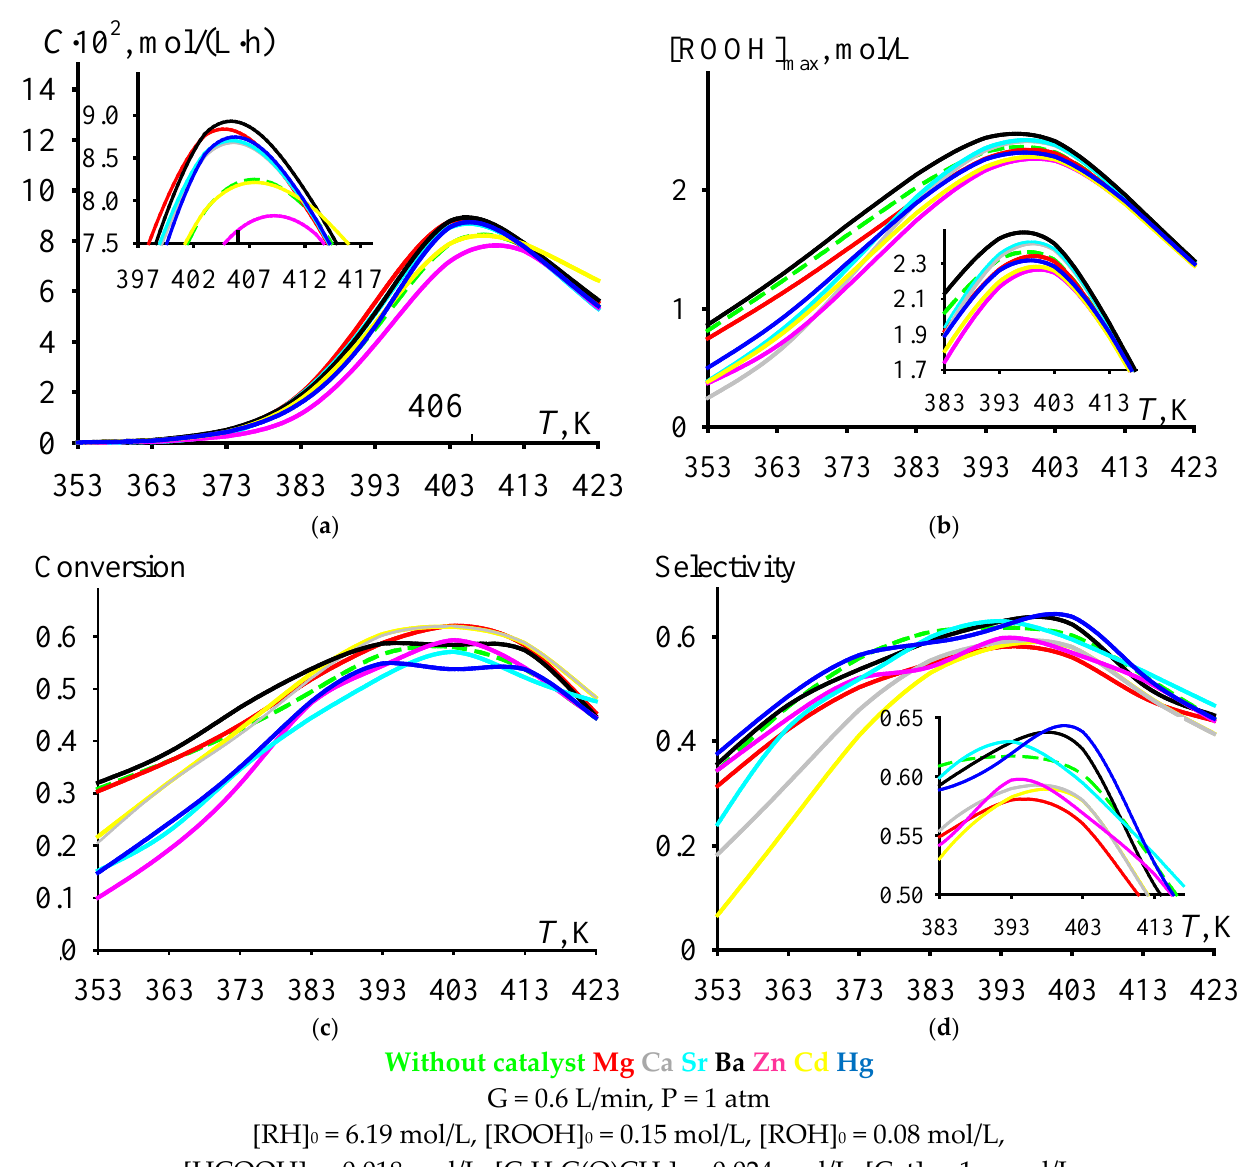
Figure 4. The dependencies of criterion C ( a ), [ROOH] max ( b ), cumene conversion at t max ( c ), and selectivity at t max ( d ) versus cumene oxidation temperature.